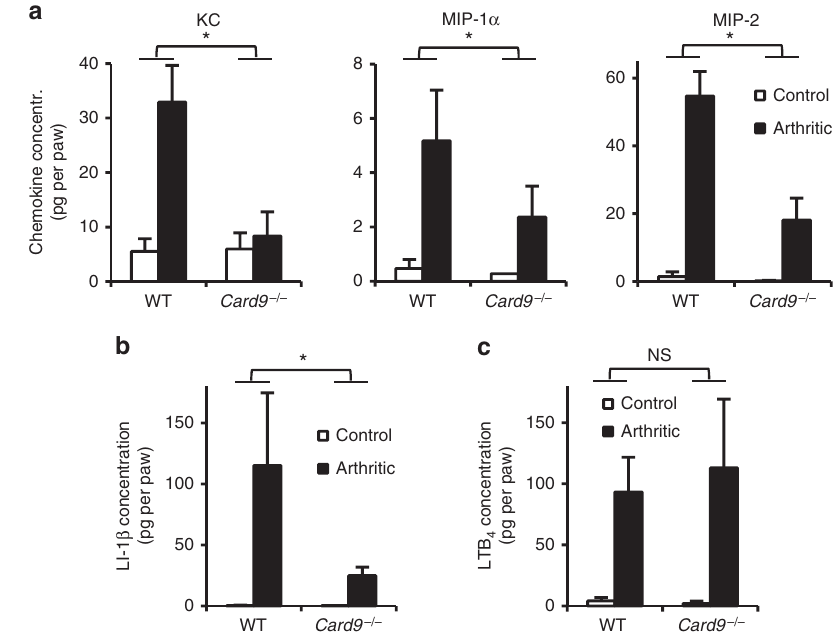
Figure 4 | CARD9 is required for the development of the inflammatory environment. ( a – c ) Wild type (WT) or Card9 (cid:2) / (cid:2) mice were subjected to K/B (cid:3) N serum-transfer arthritis as described above and the synovial area was flushed on day 4. The cell-free supernatants of the synovial infiltrates were probed using commercial ELISA assays for the indicated chemokines ( a ), cytokine ( b ) and the lipid mediator LTB 4 ( c ). Graphs represent mean and s.e.m. from 4–9 ( a ), 3–5 ( b ) or 3–4 ( c ) mice per group from three independent experiments. * P o 0.05; NS, statistically not significant (two-way ANOVA); see the text for actual P values.